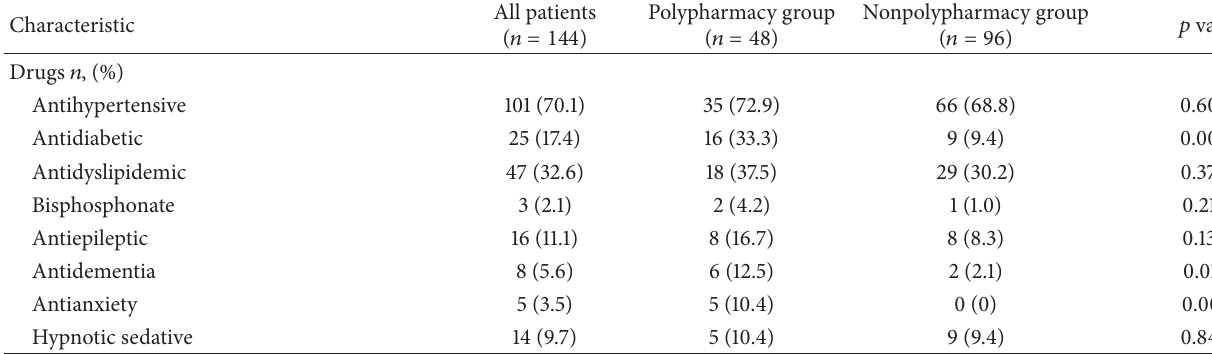
Table 4: Comparison of oral drugs being taken upon admission.